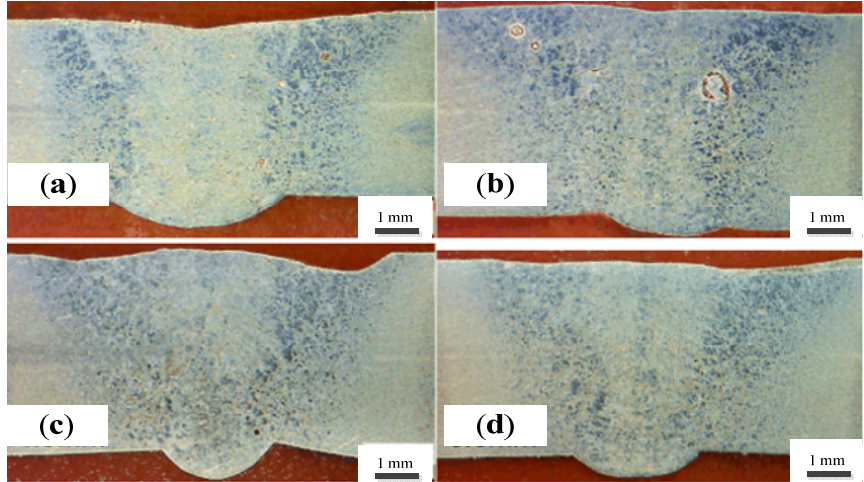
Figure 7. The cross-section morphology under different distance between heat sources: ( a ) 2.5 mm,